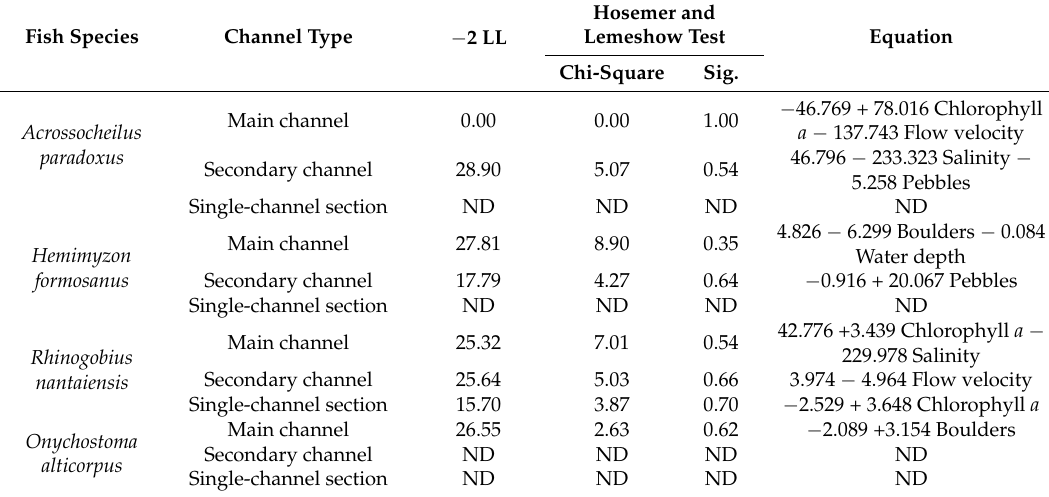
Table 3. The equation using a logistic regression in the different channel types for each fish species. “ND” means no environmental factors are chosen in the equation. “LL” is the log likelihood. Fish Species Channel Type ´ 2 LL